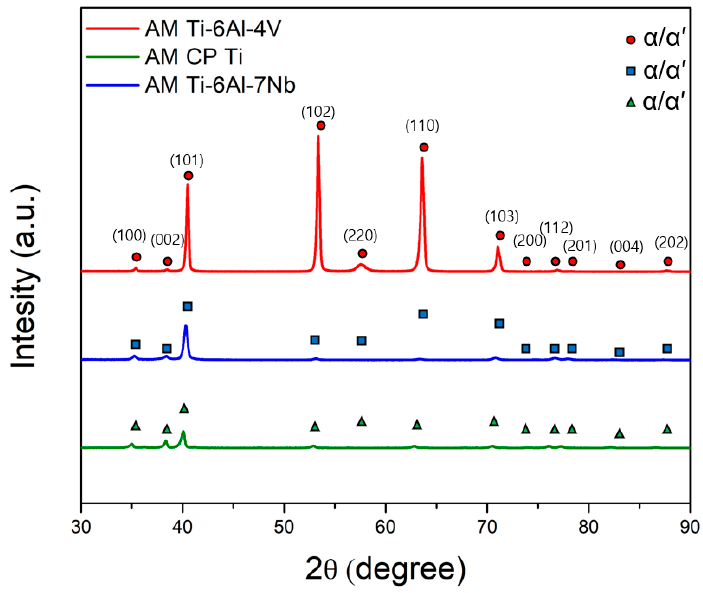
Figure 4. XRD patterns of the AM Ti–6Al–4V, AM Ti–6Al–7Nb, and AM CP Ti alloys.